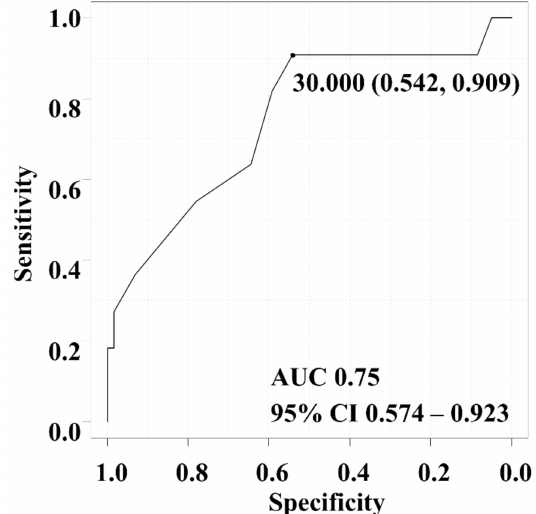
Figure 1. Receiver operating characteristic (ROC) curve analysis was used to select and validate the cut-off value for the immunohistochemical expression of PRDX4. The cut-off value was selected using a ROC and the area under the curve (AUC). The cut-off value was 30%.